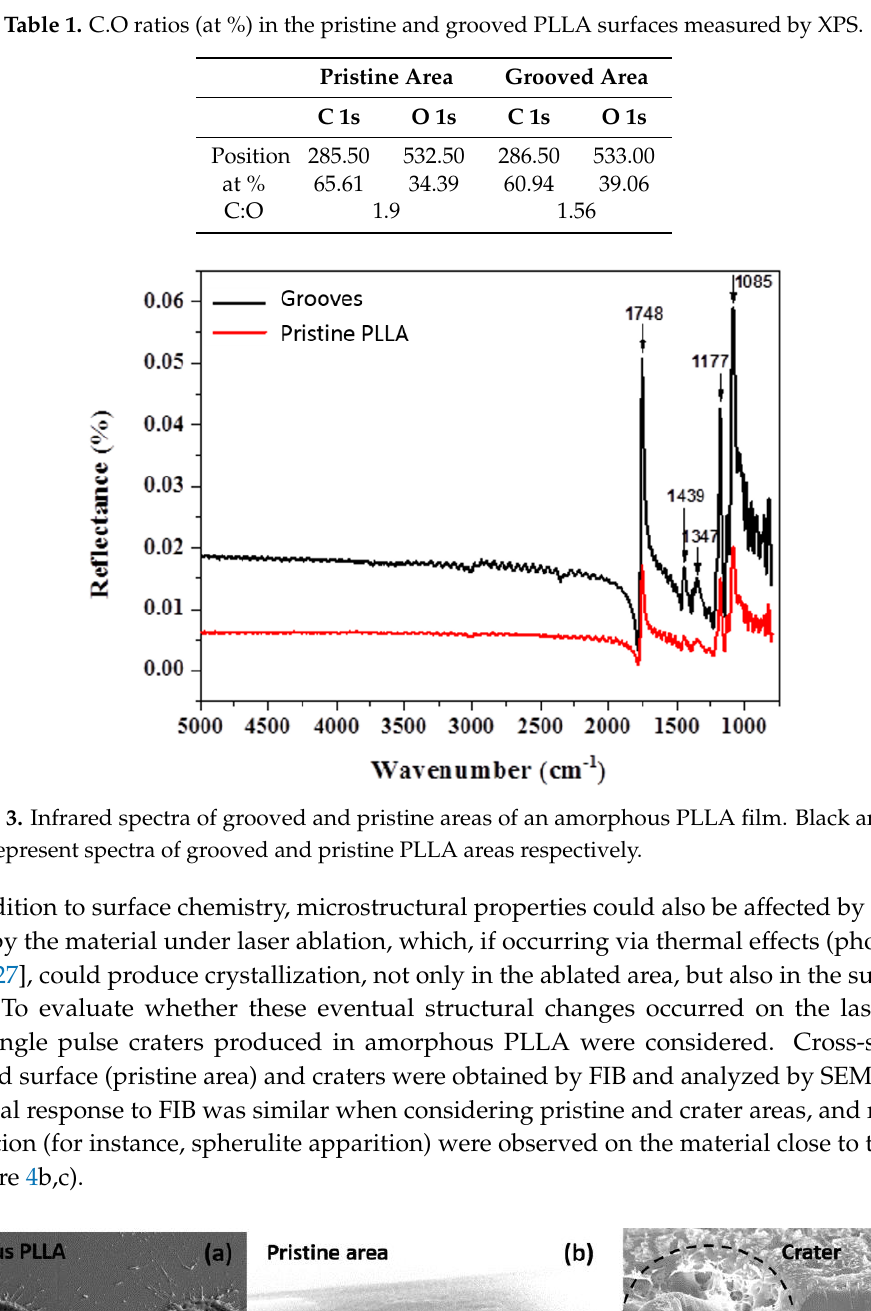
Table 1. C.O ratios (at %) in the pristine and grooved PLLA surfaces measured by XPS.